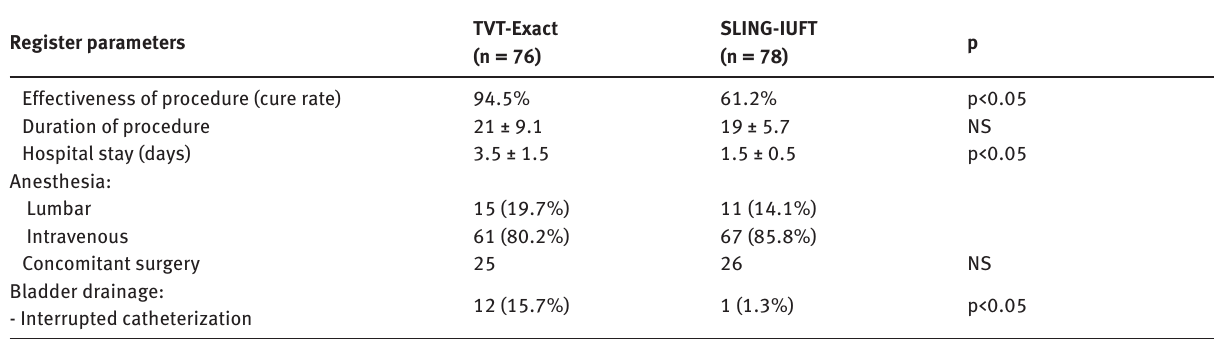
Table 2: Register data of TVT-Exact and SLING-IUFT procedure